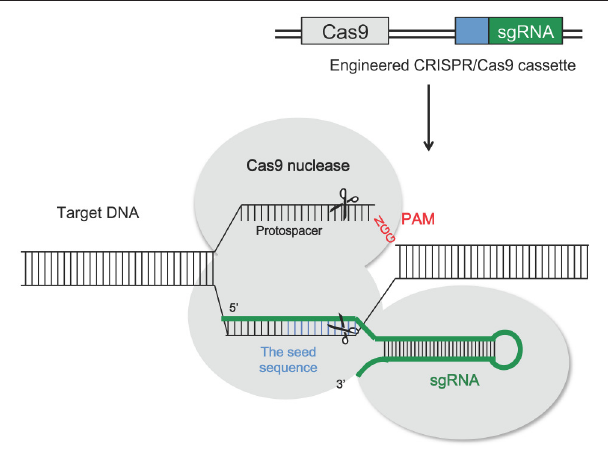
FIGURE 5 | Schematic illustration of the CRISPR/Cas9 system structure and the principle of CRISPR/Cas9-mediated genomic modifications. Cas9 can be reprogrammed to induce the cleavage of specific DNA sequences by the production of a synthetic guide RNA (sgRNA). It contains a region (seed sequence, usually 8–12 bp long, shown in blue) complementary to the target DNA on the genomic loci that mediates the binding of the Cas9 protein. The cleavage site stays 3 bp upstream of the protospacer adjacent motif (PAM, NGG; shown in red), which is required for the cleavage of the target DNA sequence. Induced DSBs of the target DNA are repaired by either NHEJ or HDR, producing gene mutations that include nucleotide insertion, deletion or substitution around the cleavage sites (see Figure 3